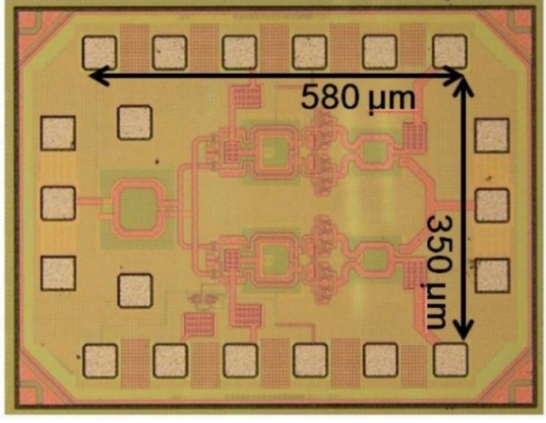
Figure 24. Transformer-based DPA in 90 nm CMOS